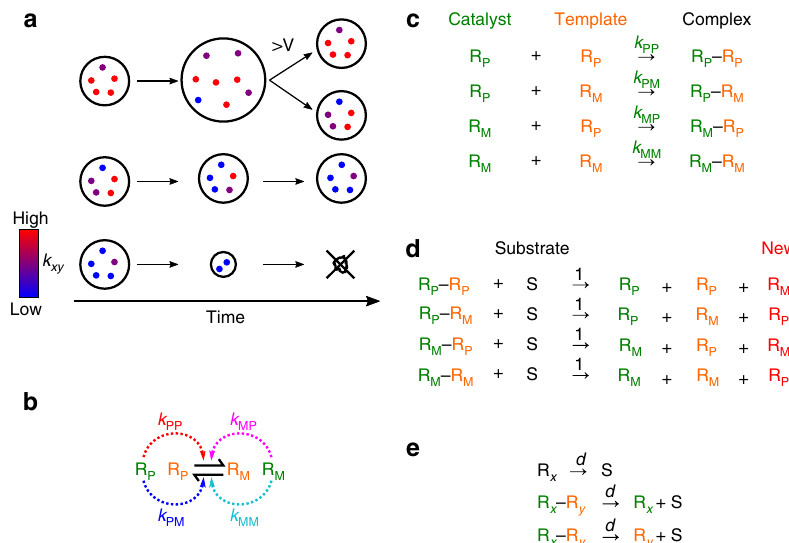
Fig. 1 Schematic of the model. a . Protocells containing replicators (substrates not shown). Colours indicate the catalytic activity of replicators k xy . A protocell with high- k xy replicators grows and divides ( top ); that with low- k xy replicators shrinks and dies ( bottom ). Replicators within a protocell evolve towards minimising k xy ( middle ). b . Schematic of replication and catalysis (see also c and d ). Solid arrows indicate replication (template ⇀ product); dotted arrows indicate catalysis (catalyst ⇢ reaction). c . Complex formation. R x denotes a replicator ( x ∈ {P, M}); R x − R y , complex between R x serving as a catalyst ( green ) and R y serving as a template ( orange ) ( y ∈ {P, M}). The complex formation rate is given by the k xy value of the catalyst. d . Replication. S denotes a substrate. A newly-synthesised replicator ( red ) is complementary to the template ( orange ), with its k xy values copied from the template with possible mutations. e . Decay. d = 0.02, unless otherwise